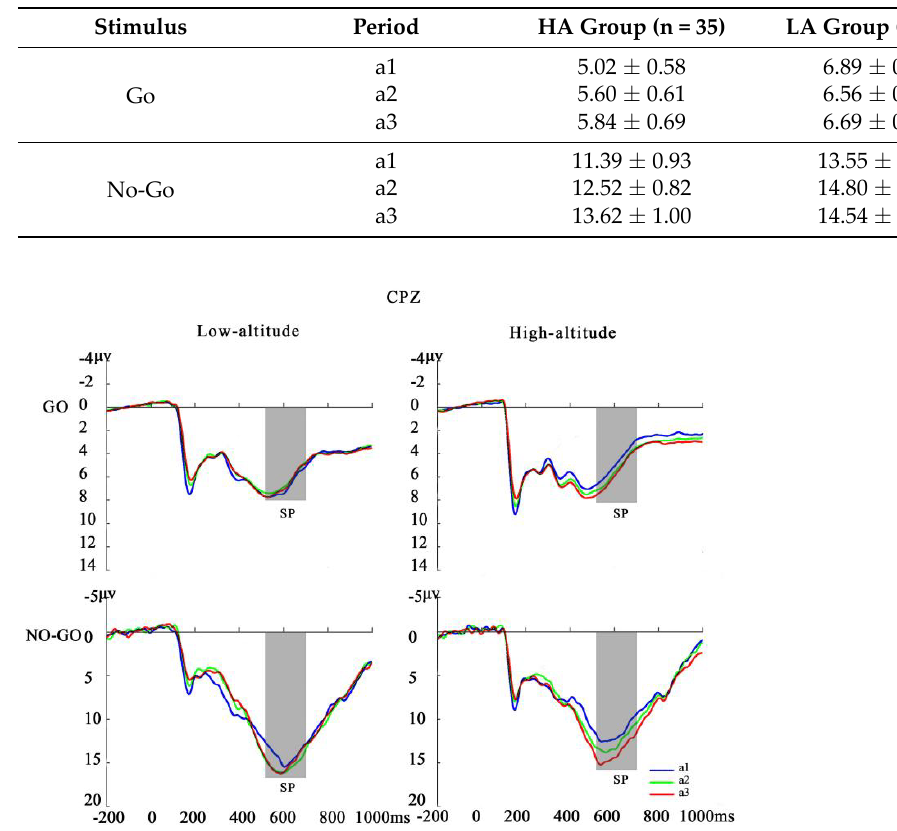
Figure 3. Stimulus-locked ERP waveforms as a function of altitude (low-altitude/high-altitude), Figure 3. Stimulus‑locked ERP waveforms as a function of altitude (low‑altitude/high‑altitude), pe‑ period (a1/a2/a3), stimulus type (Go/No-Go), and electrode site (CPZ). riod (a1/a2/a3), stimulus type (Go/No‑Go), and electrode site